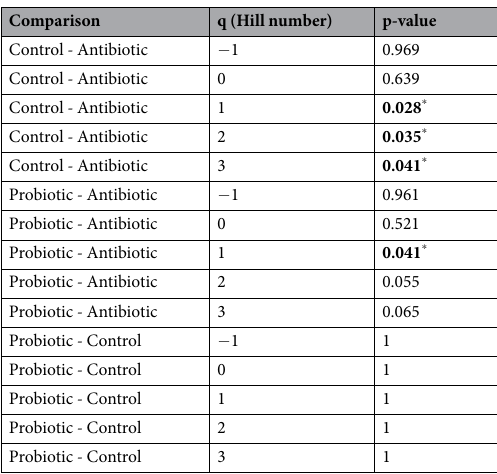
Table 4. mcpHill diversity analysis of group differences in biodiversity. * p <